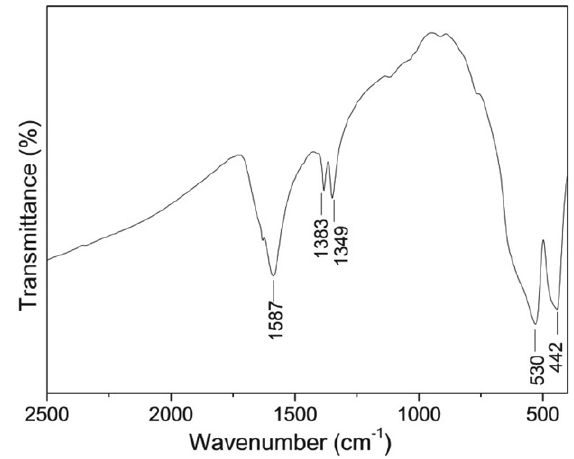
Figure 2. FTIR spectrum of Fe 2 O 3 NPs.